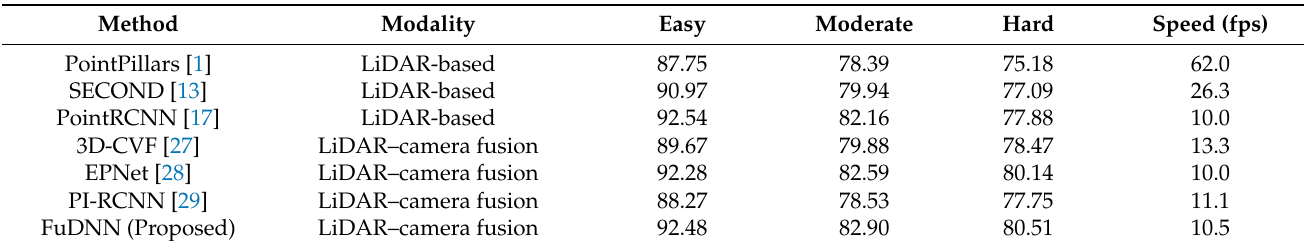
Table 3. AP comparison of different 3D object detection algorithms in the car class of KITTI validation set with IoU threshold 0.7.